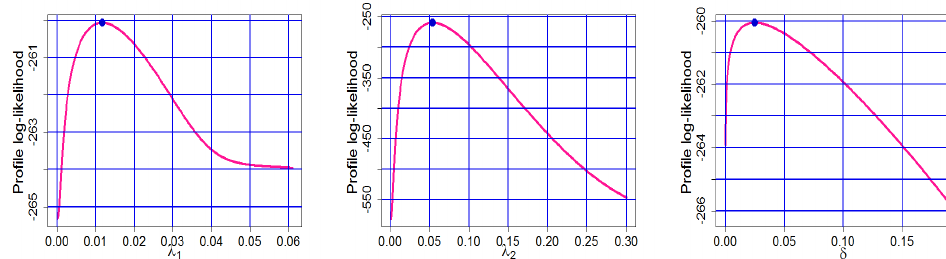
Figure 15. The plots of PLLF for Dataset. Fig. 15. The Plots of PLLF for for Dataset Fig. 15. The Plots of PLLF for for Dataset